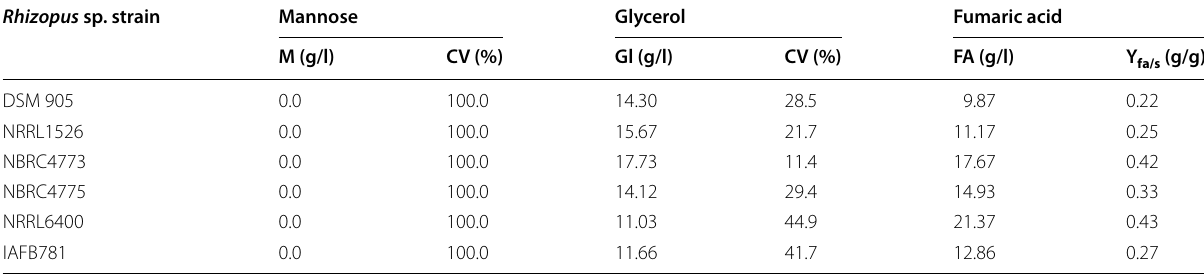
FA (g/l), fumaric acid concentration in medium after culture; M (g/l), mannose concentration in medium after culture; Gl (g/l), glycerol concentration in medium after culture; CV (%), consume value; Y fa/s (g/g), g of fumaric acid produced per g of carbon source consumed